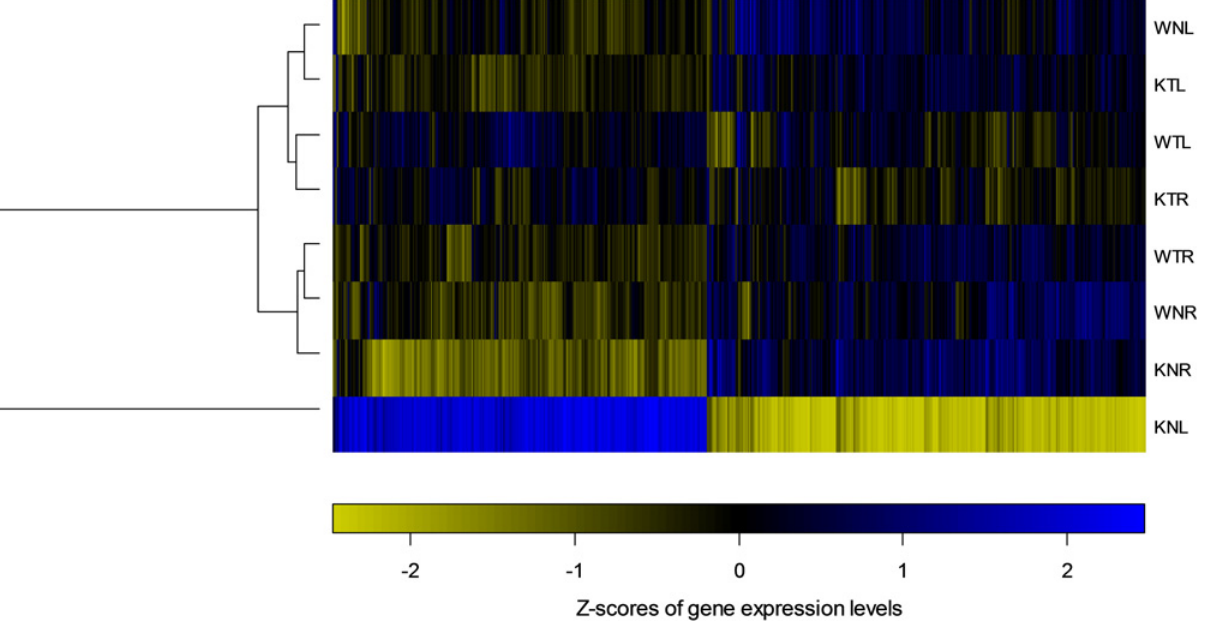
Fig 3. The heatmap representing the relative expression level of each DEG over eight sample groups. In the heatmap, color indicates the Z-score of expression relative to the mean over eight conditions. Eight conditions were clustered using hierarchical clustering.